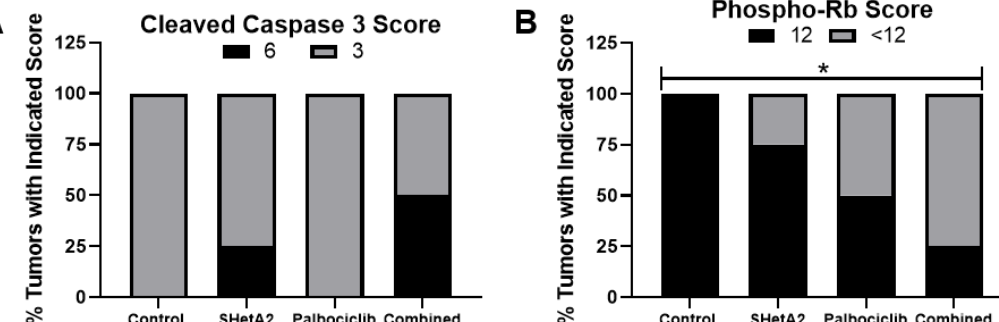
Figure 6. Stain scores of ( A ) cleaved caspase 3 and ( B ) phosphorylated pRb expression in SiHa xenograft tumors after the indicated treatments. Chi-Square Test for Trend * p = 0.03.